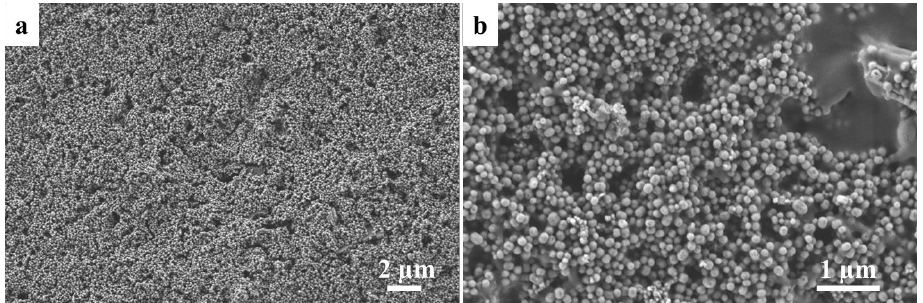
Figure 1. SEM micrographs of calcium-containing MCM-41 (Ca_MCM-41) particles at low magnification. ( a ) higher magnification; ( b ) show the homogeneity of particles size and shape.